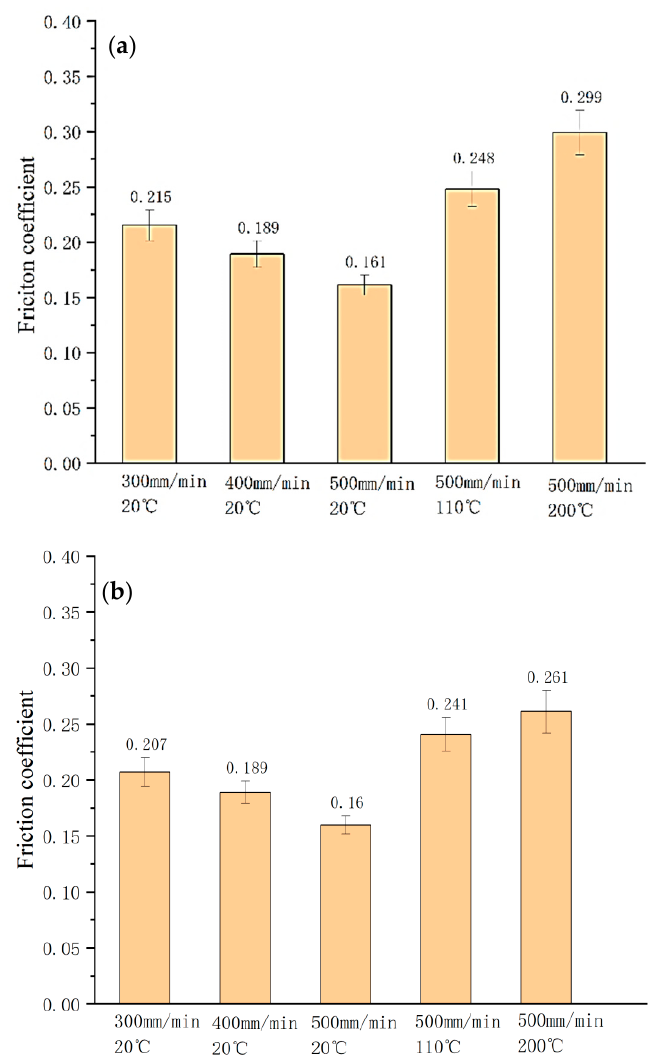
Figure 6. Friction coefficient under different conditions. ( a ) Friction coefficient of the hardened layer after laser hardening with a scanning speed of 700 mm/min. ( b ) Friction coefficient of the hardened layer after laser hardening with a scanning speed of 800 mm/min.